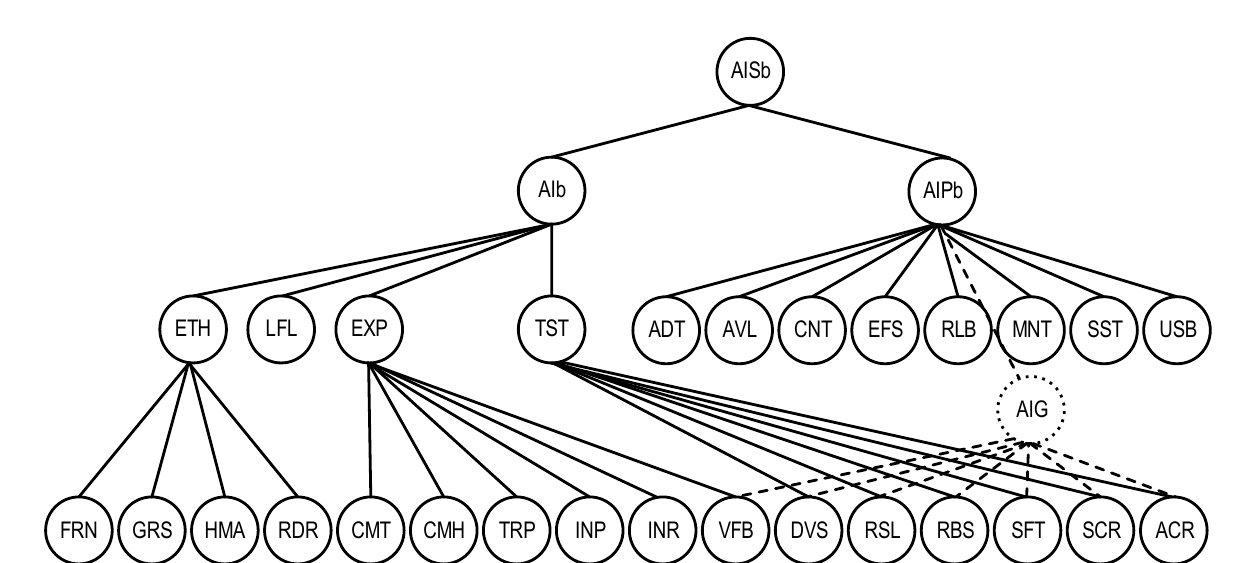
Figure 9. The graph representation of the basic AI system quality model 𝑄𝑆 𝐶ℎ𝐴𝐼𝑆𝑏 .